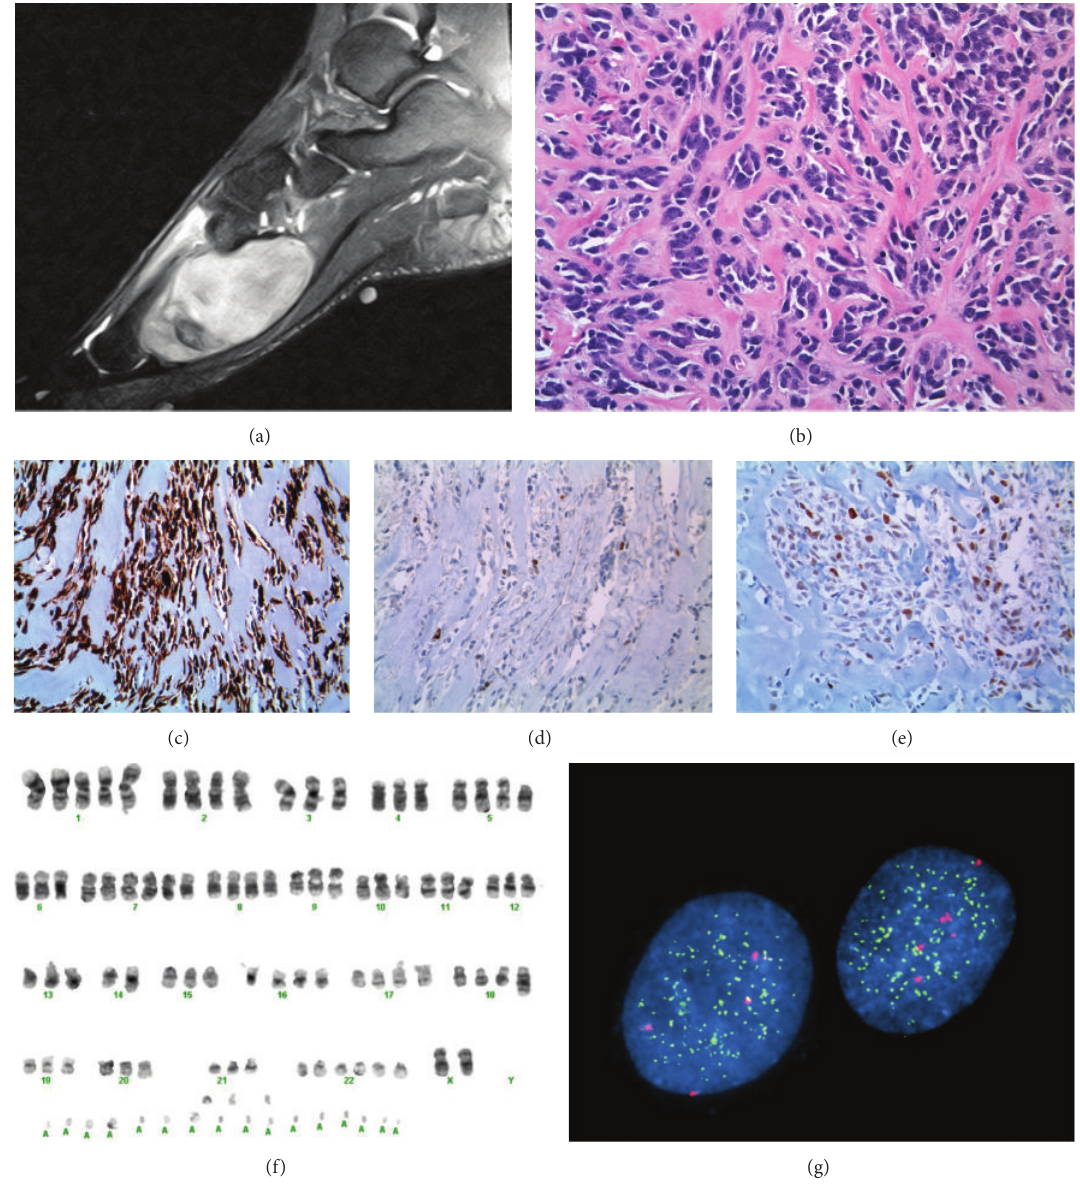
Figure 1: (a) MRI imaging. (b) Diagnostichistology of the tumor demonstrating round hyperchromatic to spindled cells surrounded by a densely hyalinized stroma. Hematoxylin-eosin, original magnification × 200. (c) Desmin immunohistochemical stain showing strong diffuse cytoplasmic expression of desmin. (d) Although sparse, individual cells demonstrated strong nuclear staining with myogenin. Myogenin immunohistochemical stain. (e) Several cells demonstrated strong nuclear staining with MDM2 immunohistochemical stain. (f) Representative G-banded karyogram demonstrating a complex abnormal hyperdiploid clone. These cells contained from 20 to 50 double minutes, shown by fluorescence in situ hybridization (FISH) to be amplification of the MDM2 gene. (g) Fluorescence in situ hybridization (FISH) with Zytovision MDM2 probe (green) and a 12 centromere probe as control (red) revealed a subset of interphase cells, as shown here, exhibiting multiple green signals confirming MDM2